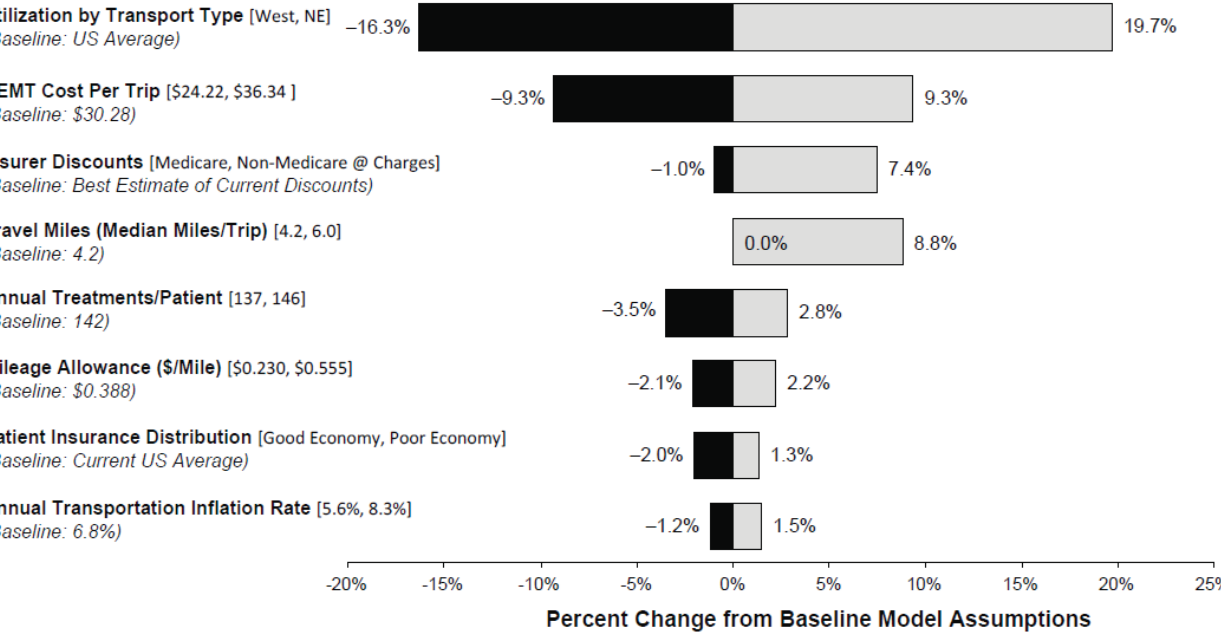
Black bars represent outcomes based on minimum plausible values. Gray bars represent outcomes based on maximum plausible values. Numbers in square brackets to the right of the labels denote the range of values